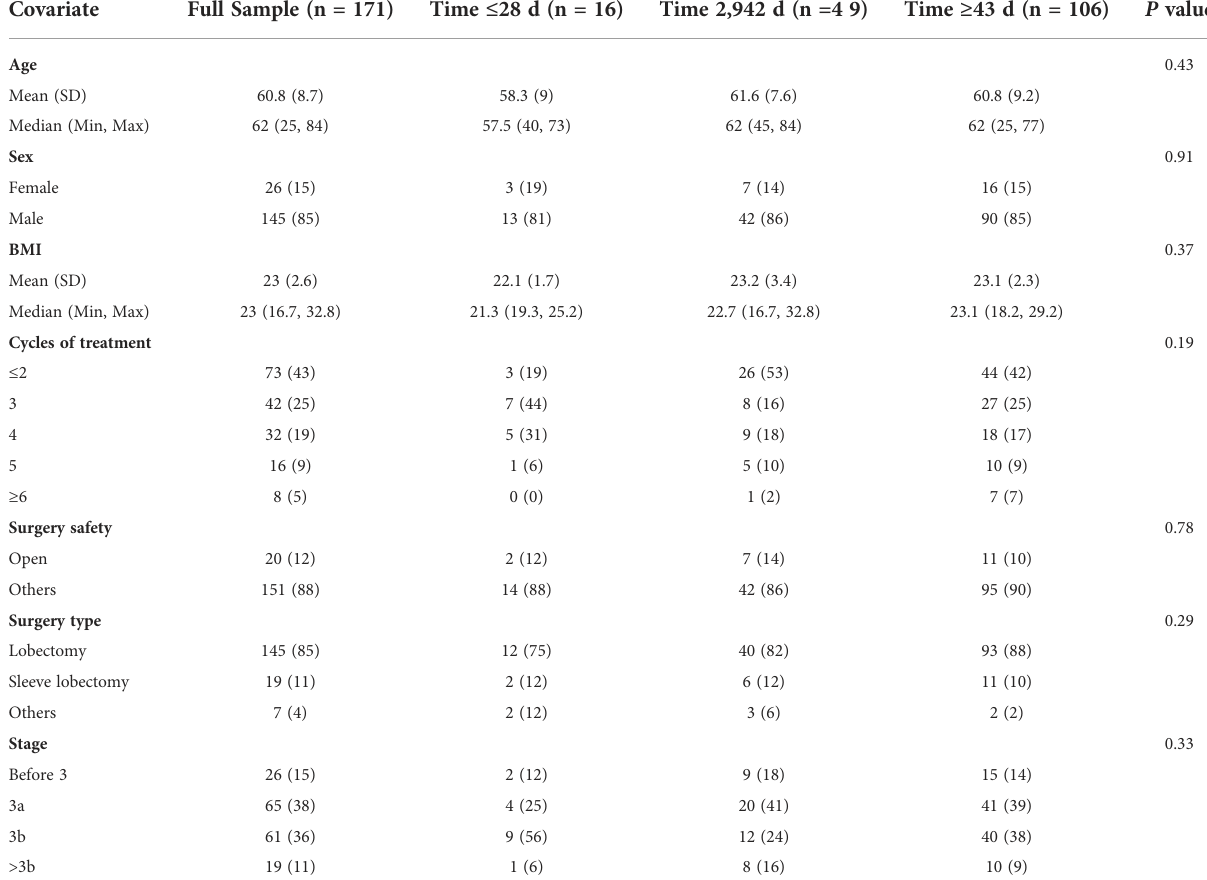
TABLE 1 Baseline characteristics of patients with